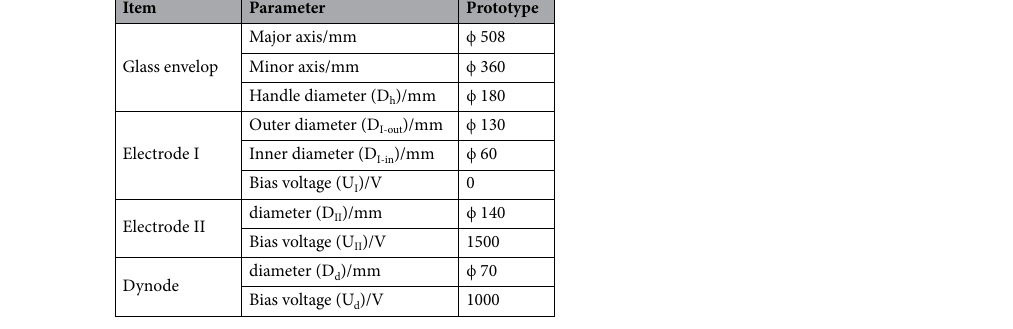
Table 1. Parameters of the 20-in. Dynode-MCP-PMT